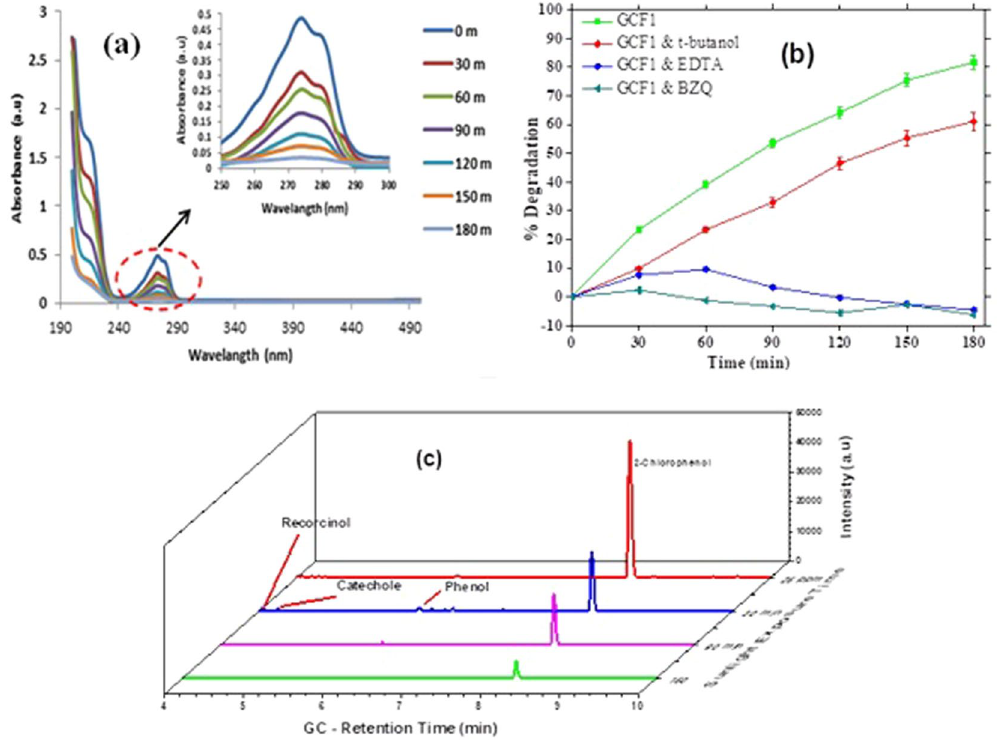
Figure 11. (a ) UV-Visible absorption spectra of 2-CP degradation over GCF1. (b) Influence of reactive species scavenging on photocatalytic activity; (c) GC Analysis